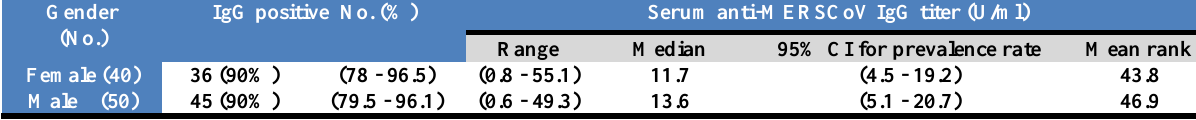
Table, 3: The anti-MERS-CoV IgG positivity rate and titer according to gender. Gender